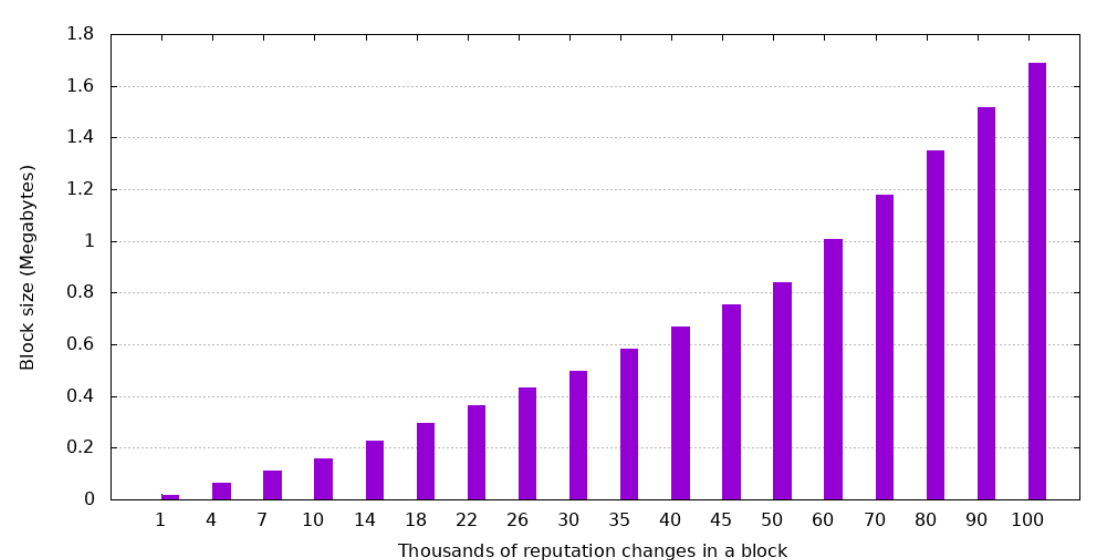
Figure 14. Impact of reputation changes on the size of a